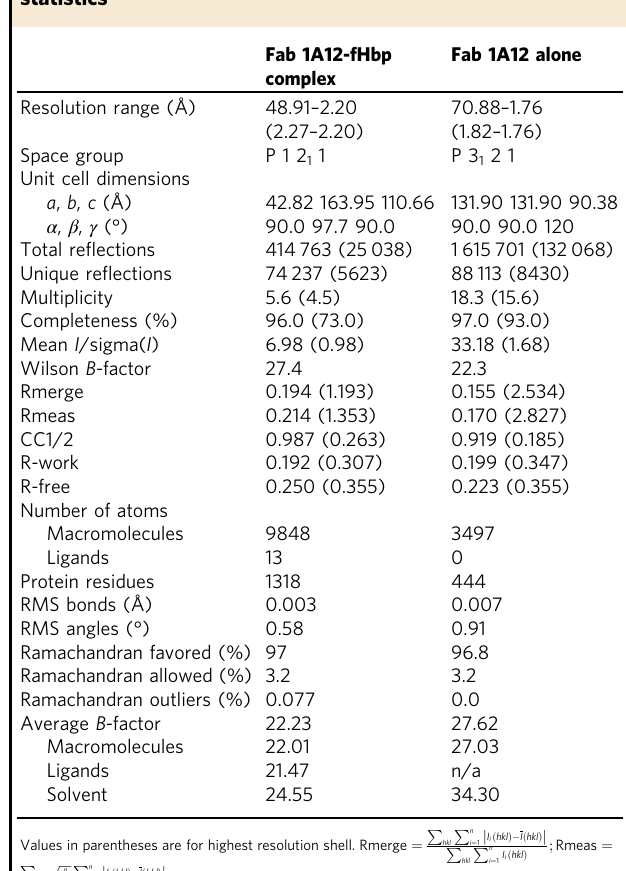
Table 2 X-ray data collection, processing, and re fi nement statistics